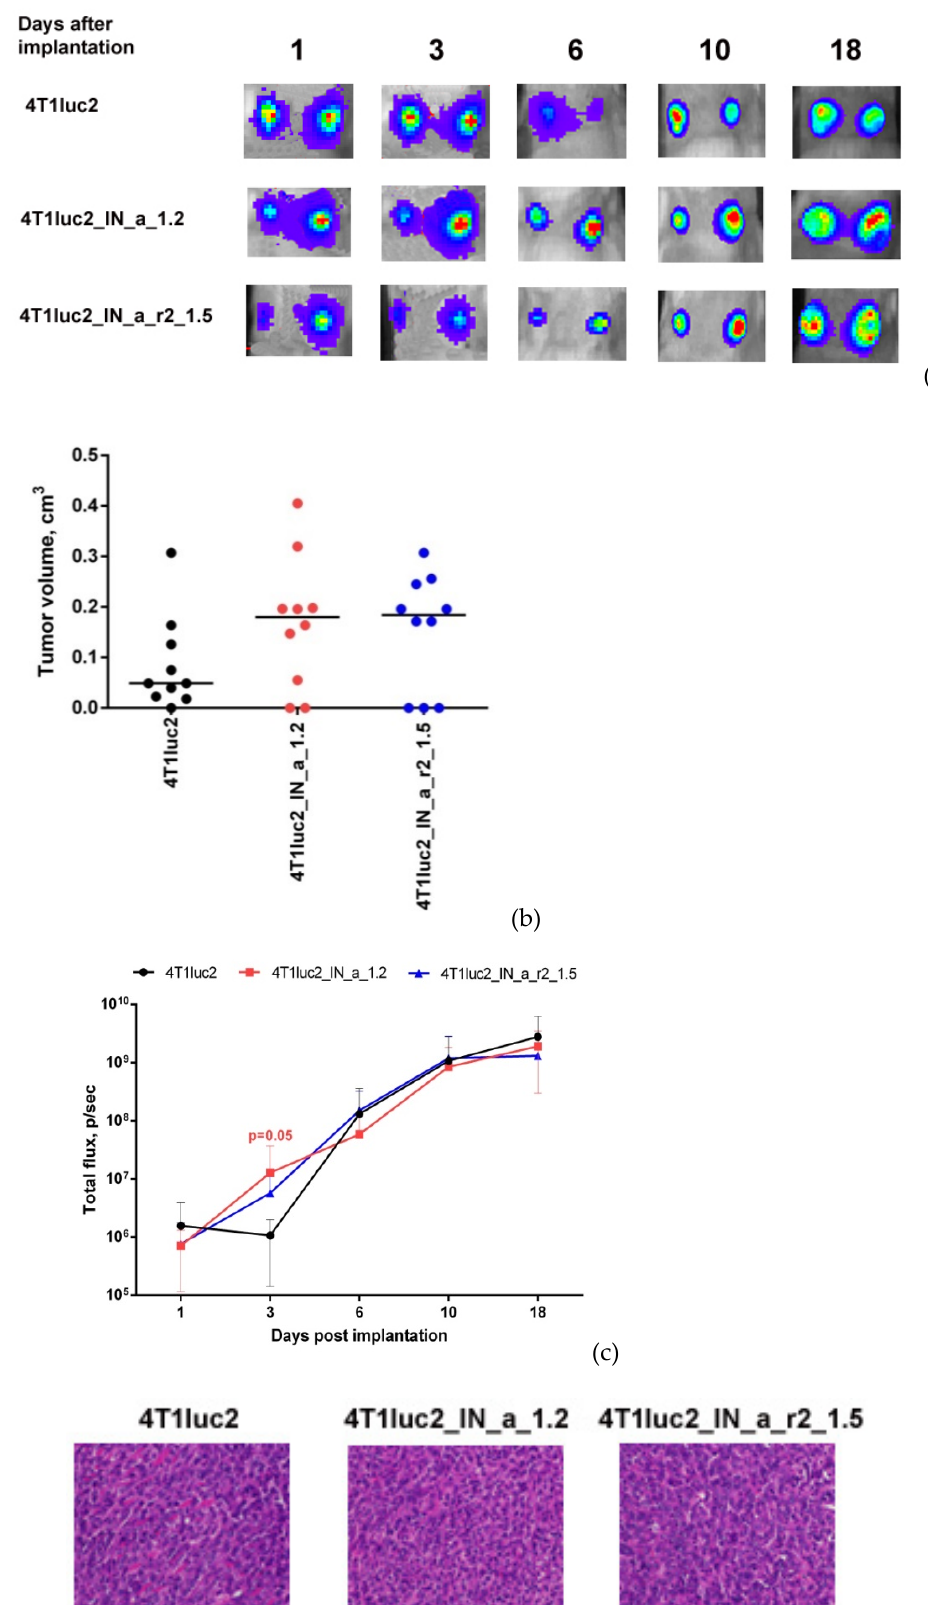
Figure 5. Stable expression of enzymatically active consensus HIV-1 clade A integrase with or without drug resistance mutations has no effect on the tumorigenic potential of murine mammary gland adenocarcinoma 4T1luc2 cells. Bioluminescent images of areas of implantation of tumor cells by in vivo bioluminescence showing growth of representative tumors formed by 4T1luc2 cells (pa- rental) and 4T1luc2_IN_a_1.2 and 4T1luc2_IN_a_r2_1.5 clones ( a ); quantification of photon flux from the areas of implantation of tumor cells monitoring tumor growth ( b ); palpable tumor size at the experimental end-point by day 19 ( c ); histochemical characterization of the solid tumors formed by 4T1luc2, IN_a expressing 4T1luc2_IN_a_1.2, and IN_a_r2 expressing 4T1luc2_IN_a_r2_1.5 cells ( d ). Scales on the right side of bioluminescent images demonstrate the intensity of BLI in color. Growth of tumors was assessed as the average total photon flux ( p /sec) from the sites of implanta- tion on days 1–18 post-implantation; ( b ) data represent mean ± SD; ( c ) line bars represent the me- dian values. Images of H&E stained tumor sections were done at magnification × 400 by Leica DM500 camera (Wetzlar, Germany). Statistical comparison was done by Kruskal–Wallis and Mann–Whitney tests and did not detect significant differences between the groups ( p ≥ 0.05), except for the tendency for difference between 4T1luc2_IN_a_1.2 and parental 4T1luc2 cells on day 3 after implantation ( b ). Next, we evaluated if expression of IN could influence the metastatic potential of tumor cells. For that, we measured ex vivo total photon flux emitted from the organs at the experimental end-point, as we have previously shown that it adequately represents the number of organ infiltrating tumor cells expressing luciferase and can be used as high throughput approach of assessing the metastatic activity [28]. At the experimental end- point, we excised lungs, livers, and spleens of mice implanted with IN-expressing and parental 4T1luc2 cells and subjected them to ex vivo BLI. Total flux exceeded the signal level ascribed to one Luc-expressing 4T1 cell (6000 photons/sec; Reference [28]) was de- tected only in the murine lungs (Figure 6a). BLI could not reliably register photon emis- sion from either liver or spleen (Figure 6a), indicating that these organs were infiltrated with very few tumor cells, corroborating our earlier findings of a compromised meta- static potential of Luc expressing 4T1 cells [60]. Total flux emitted from lungs of mice bearing IN expressing tumors did not differ from that for mice with tumors induced by 4T1luc2 ( p > 0.1; Figure 6a). We performed histological assessment of H&E sections of FFPE blocks prepared from the lung tissues to find single metastases in the lungs of mice in all three groups (Figure 6 b–j; on the average 1 ± 0,5 per mouse). Metastases were con- stituted by single tumor cells surrounded by severe inflammatory infiltrates, specifically